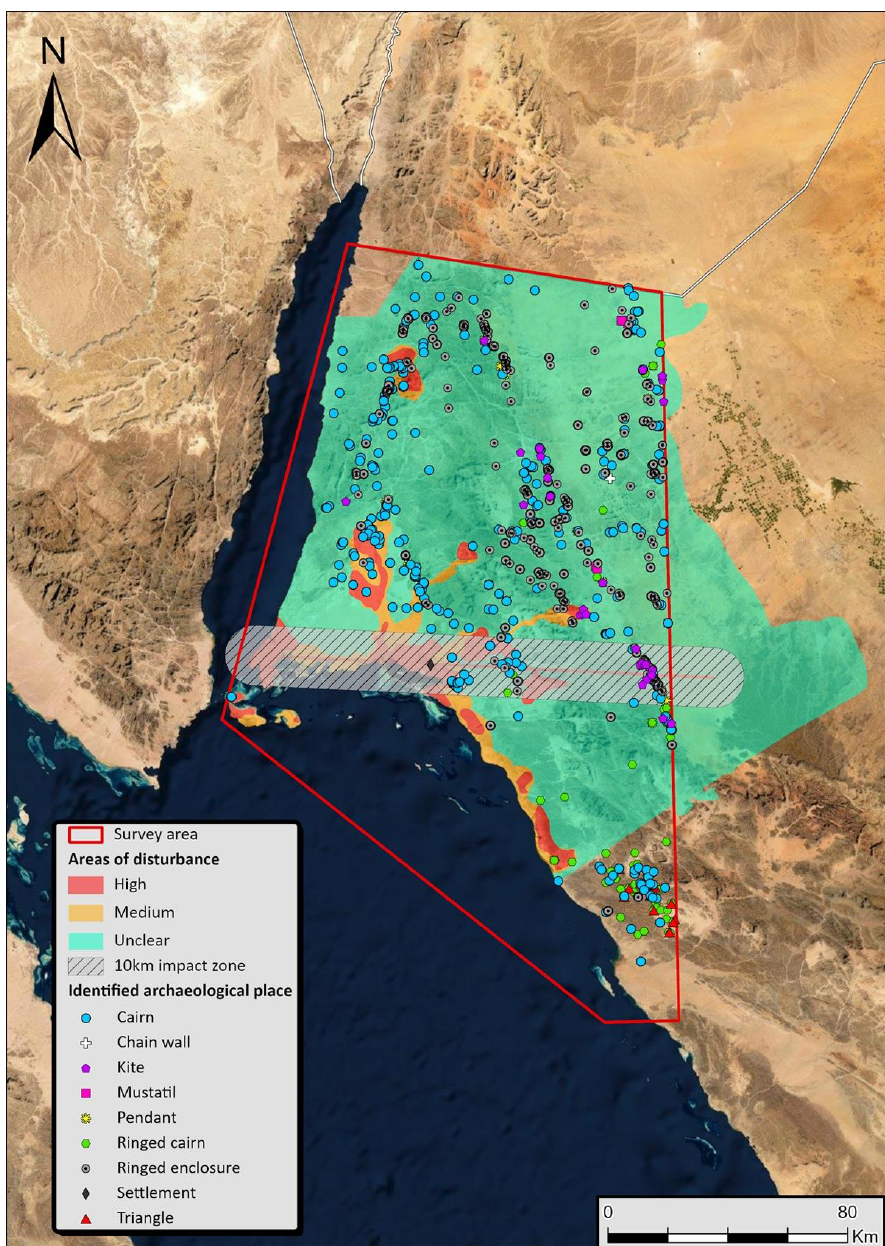
Figure 12. Neom development impact overlaying the distribution of main site types recorded. A 10 km buffer zone has been added to the Line